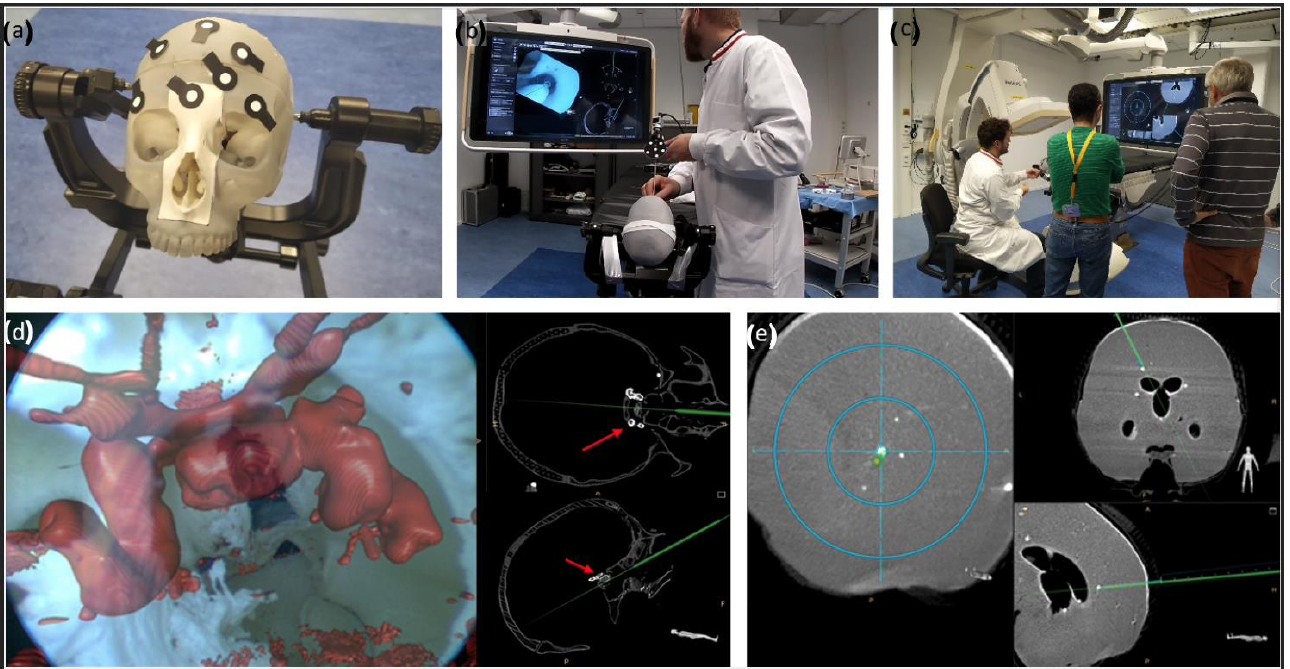
Figure 8. ( a ) Head phantom blocked on a clamp, equipped with optical markers. ( b ) Augmented reality-navigated endonasal skull-base surgery simulation. ( c ) Augmented reality-navigated brain biopsy simulations. ( d ) Skull-base surgery simulation. The endoscopic view is augmented with the critical structures of interest, as well as the trajectory of the endoscope being overlaid onto the CBCT image. ( e ) Brain biopsy simulation. A tracked needle is inserted inside the brain, throughout the skull, and its trajectory is overlaid onto the CBCT image.